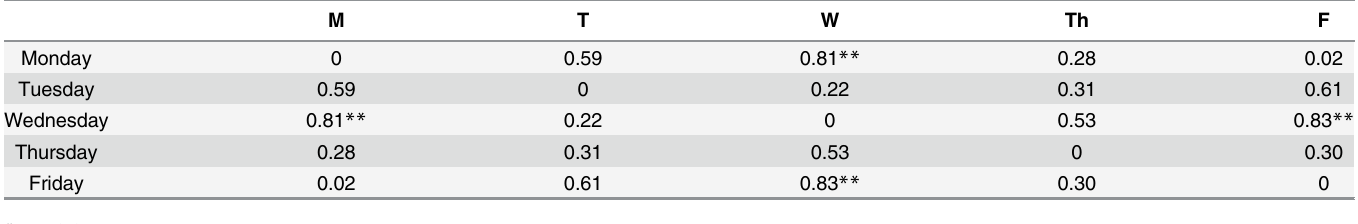
Table 1. Pairwise comparisons (Tukey ’ s HSD) between weekdays in Study 2. Cells contain absolute differences in mean reaction times